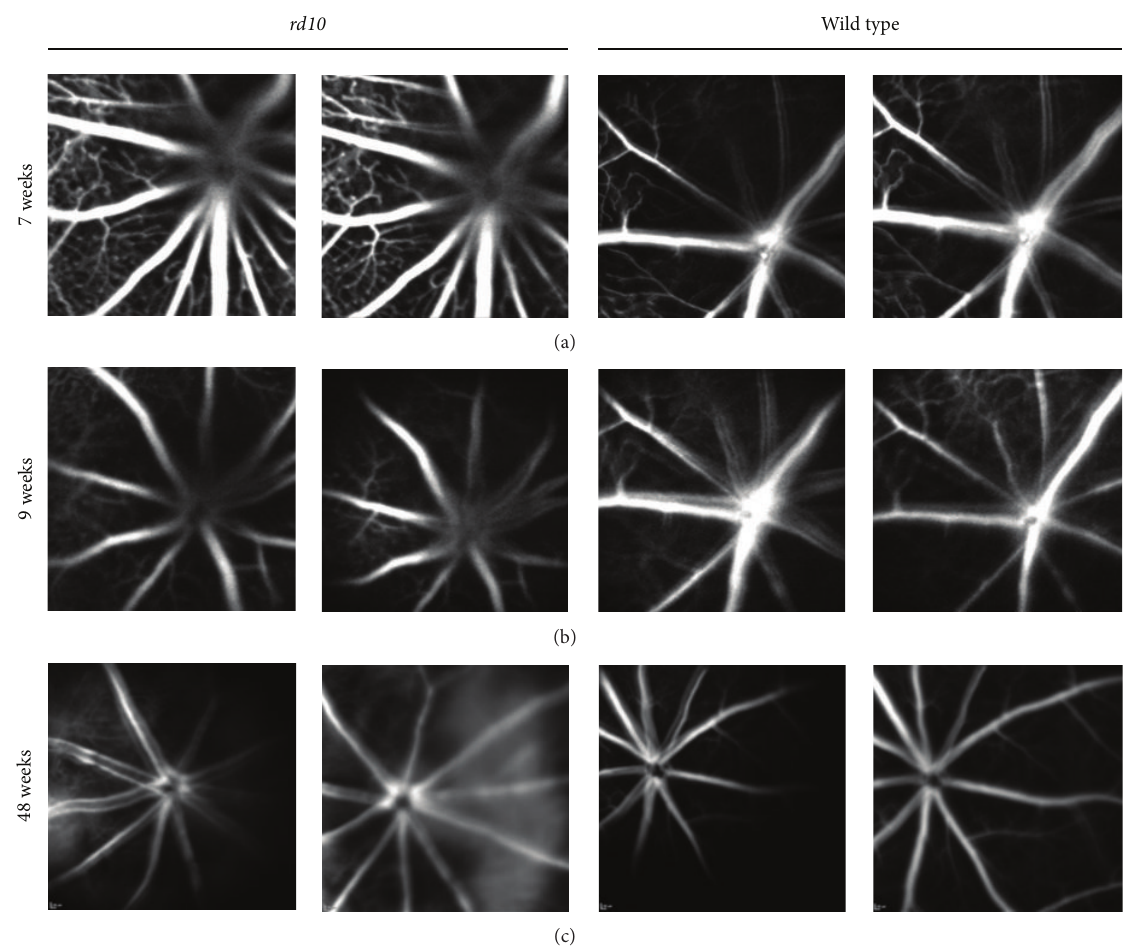
Figure 3: Fluorescein angiography in wild type versus rd10 mice. In 7-, 9-, and 48-week old mice, no significant differences in vasculature could be observed between wild type and rd10 after intraperitoneal application of